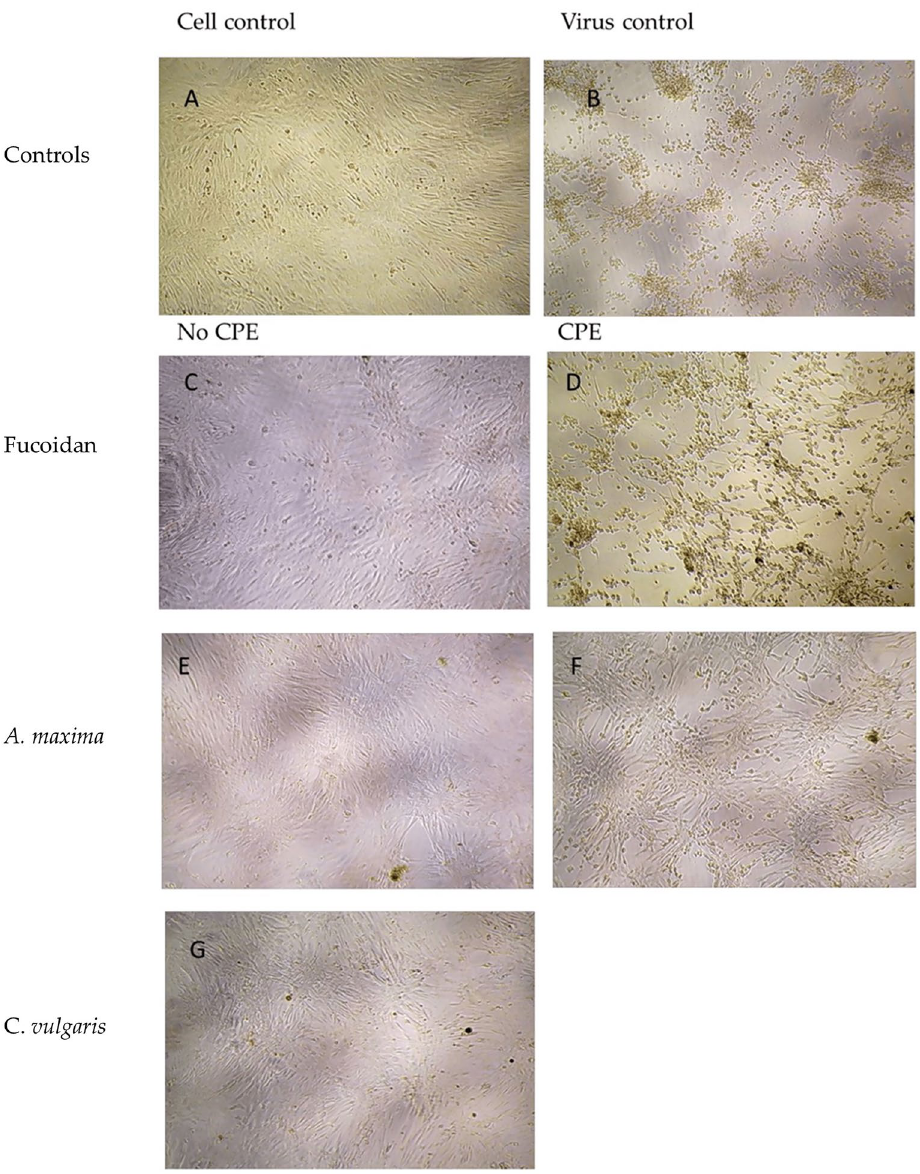
Figure 1. Inverted microscopic photographs representative of cultures at 96 h post infection. Vero cells were infected with 100 TCID 50 /ml of SARS-CoV-2 and treated with 70 μg/ml of algae. ( A ) Uninfected Vero cells; ( B ) Vero cells infected with SARS-CoV-2 presenting CPE consisting of cell detachment and culture degeneration; ( C ) Vero cells treated with fucoidan. Some of the cell cultures show CPE. ( D ) Cells treated with A. maxima , CPE is present in some of the cultures. ( G ) Cells treated with C. vulgaris , no CPE was detected in any of the